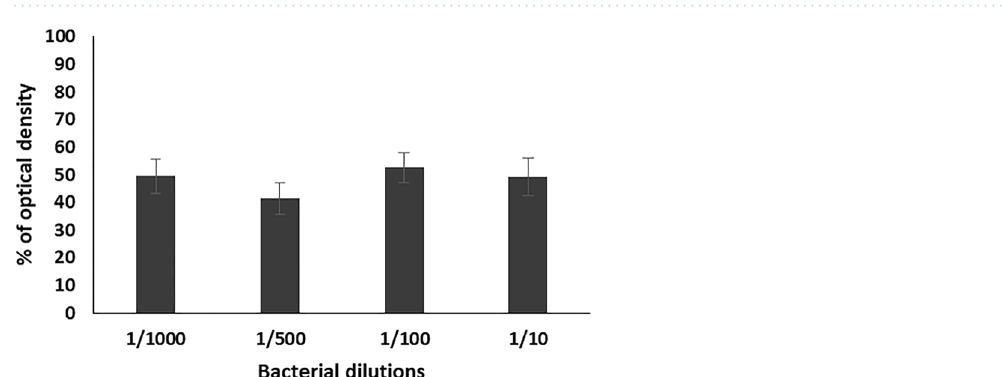
Figure 2. TEM images of the six different enterococcal bacteriophages ( a ) phage EPA, ( b ) phage EPB, ( c ) phage EPC, ( d ) phage EPD, ( e ) phage EPE, ( f ) phage EPF, with scale bar 100 nm.